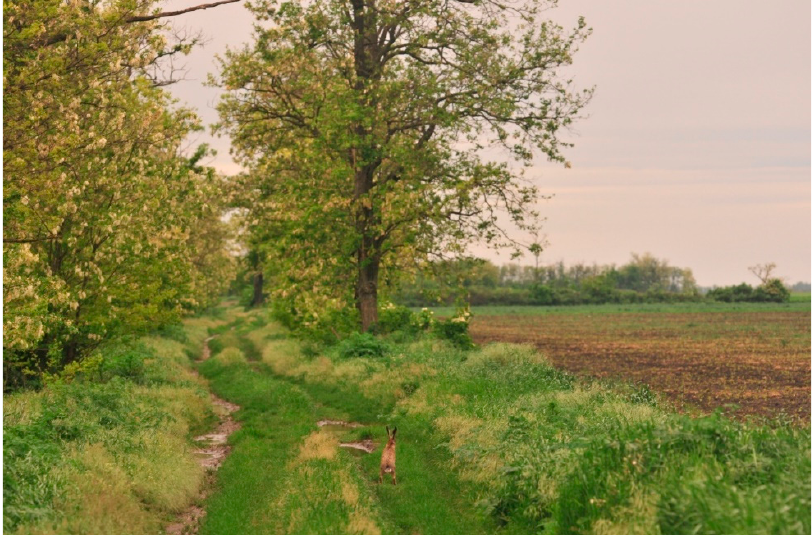
Figure 8. Interspaced verge, Kondoros (Photo: Zsuzsanna Sutyinszki).